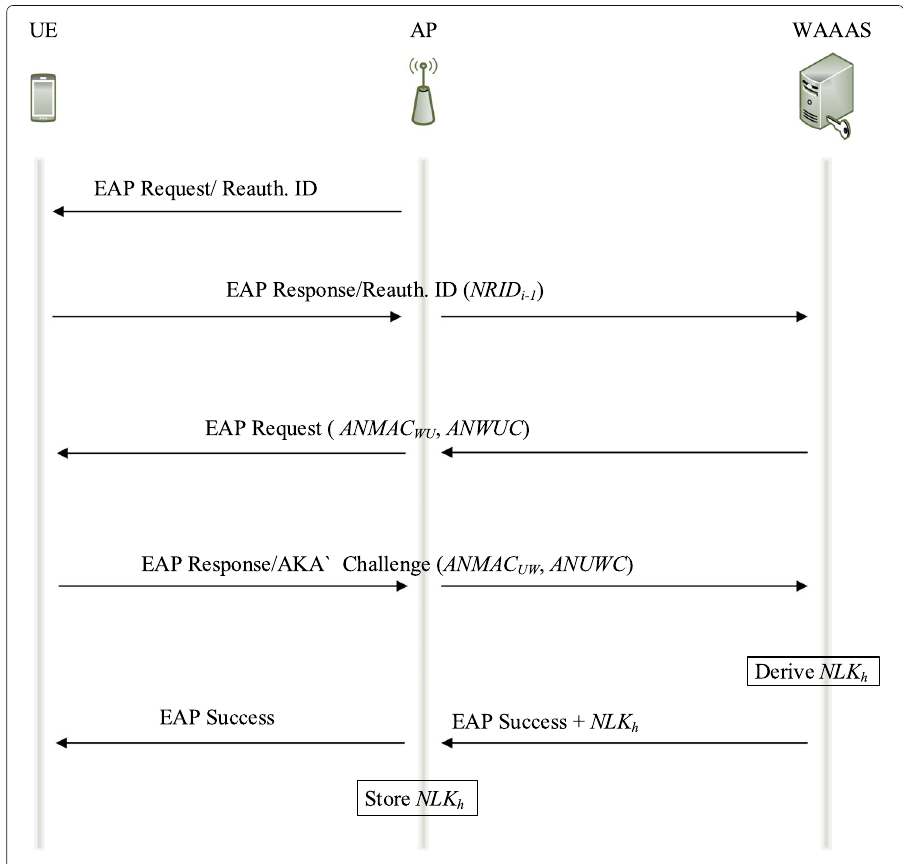
Fig. 5 Intra WLAN re-authentication